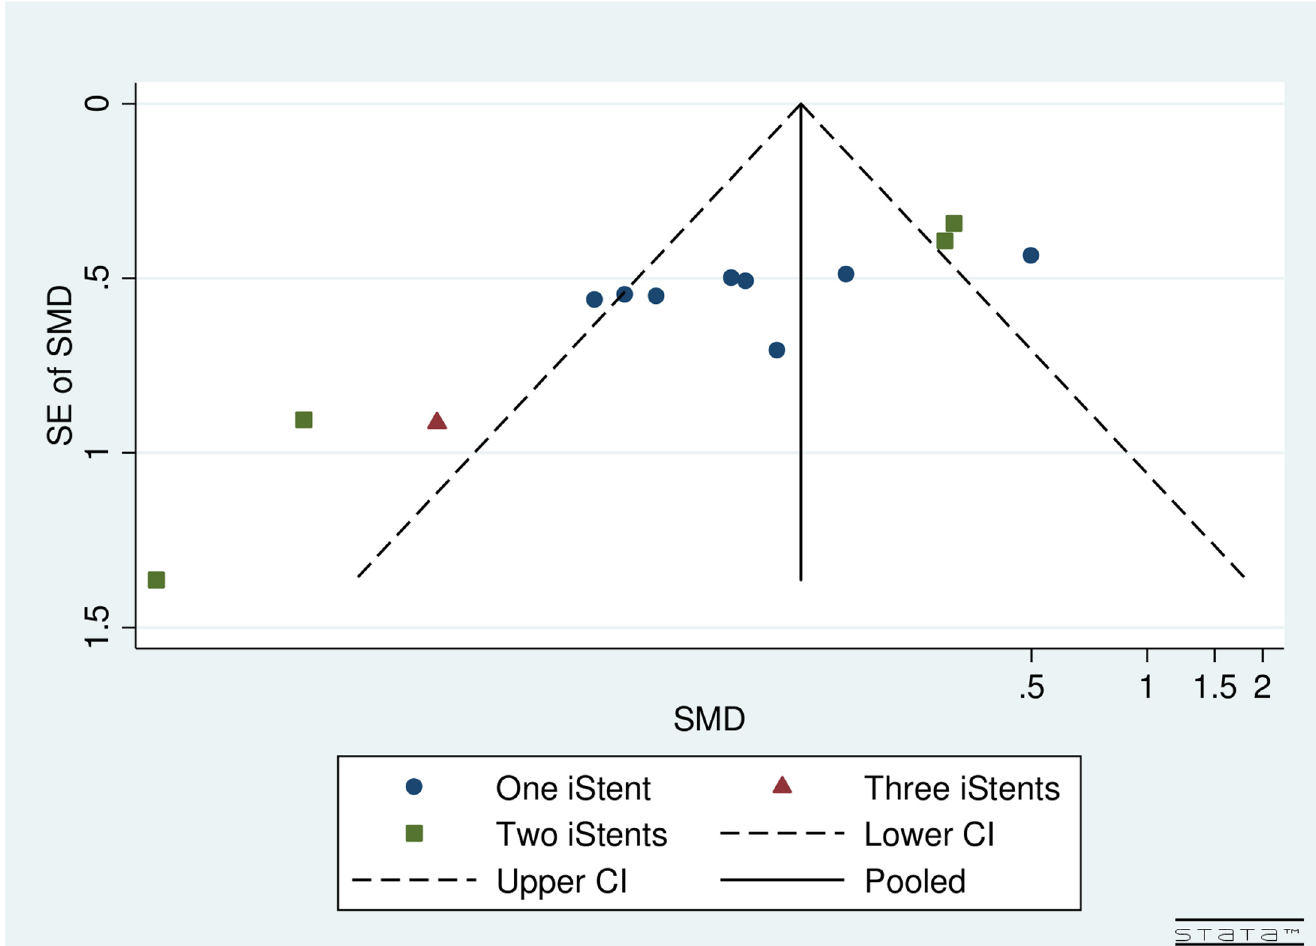
Fig 3. Funnel plot for studies examining pre- and post-operative IOP by number of iStents